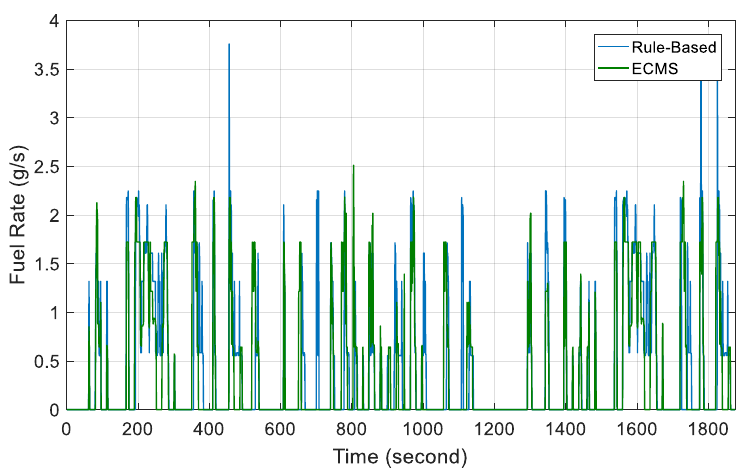
Figure 13. Comparison of fuel consumption rate in urban cycle.